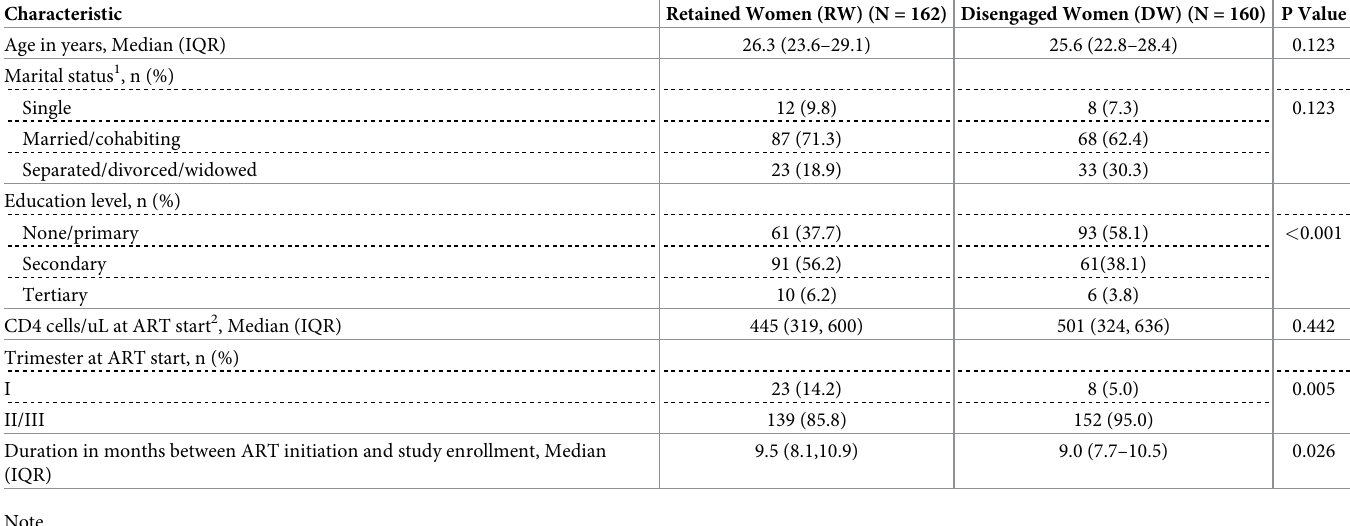
Table 1. Demographic and clinical characteristics of retained and disengaged women at study enrollment. Characteristic